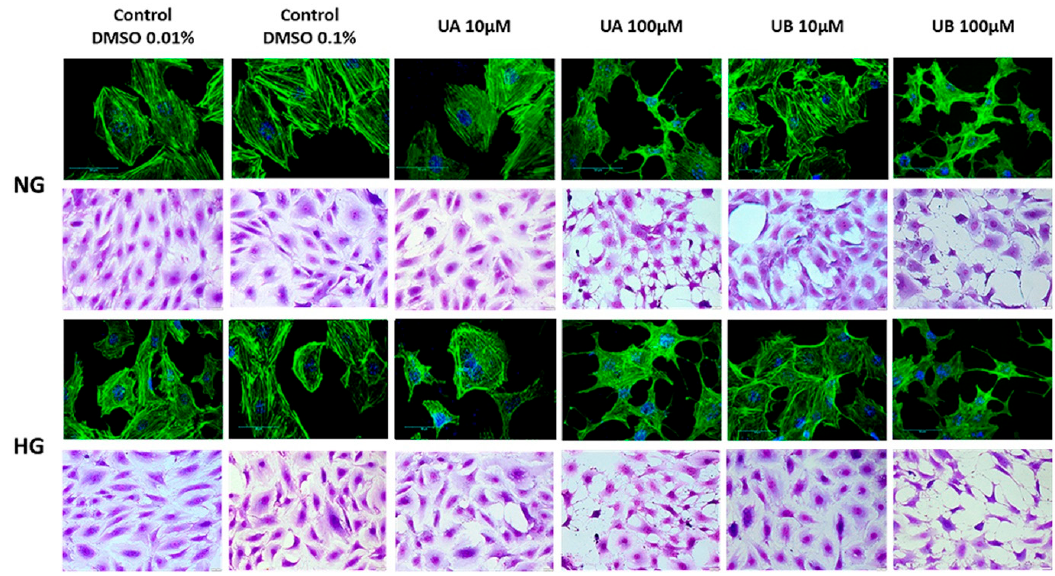
Figure 5. Urolithins at high concentrations disrupted podocyte morphology and structure. Podocytes were cultured on glass coverslips for 7 d in normal (5.5 mM, NG) or high (25 mM, HG) glucose. For the last 48 h, the cells were incubated with 10 µM and 100 µM UA or UB and subsequently stained with crystal violet or phalloidin/Alexa 488. Media containing respective vehicle concentrations served as the controls. Representative pictures out of three independent experiments.